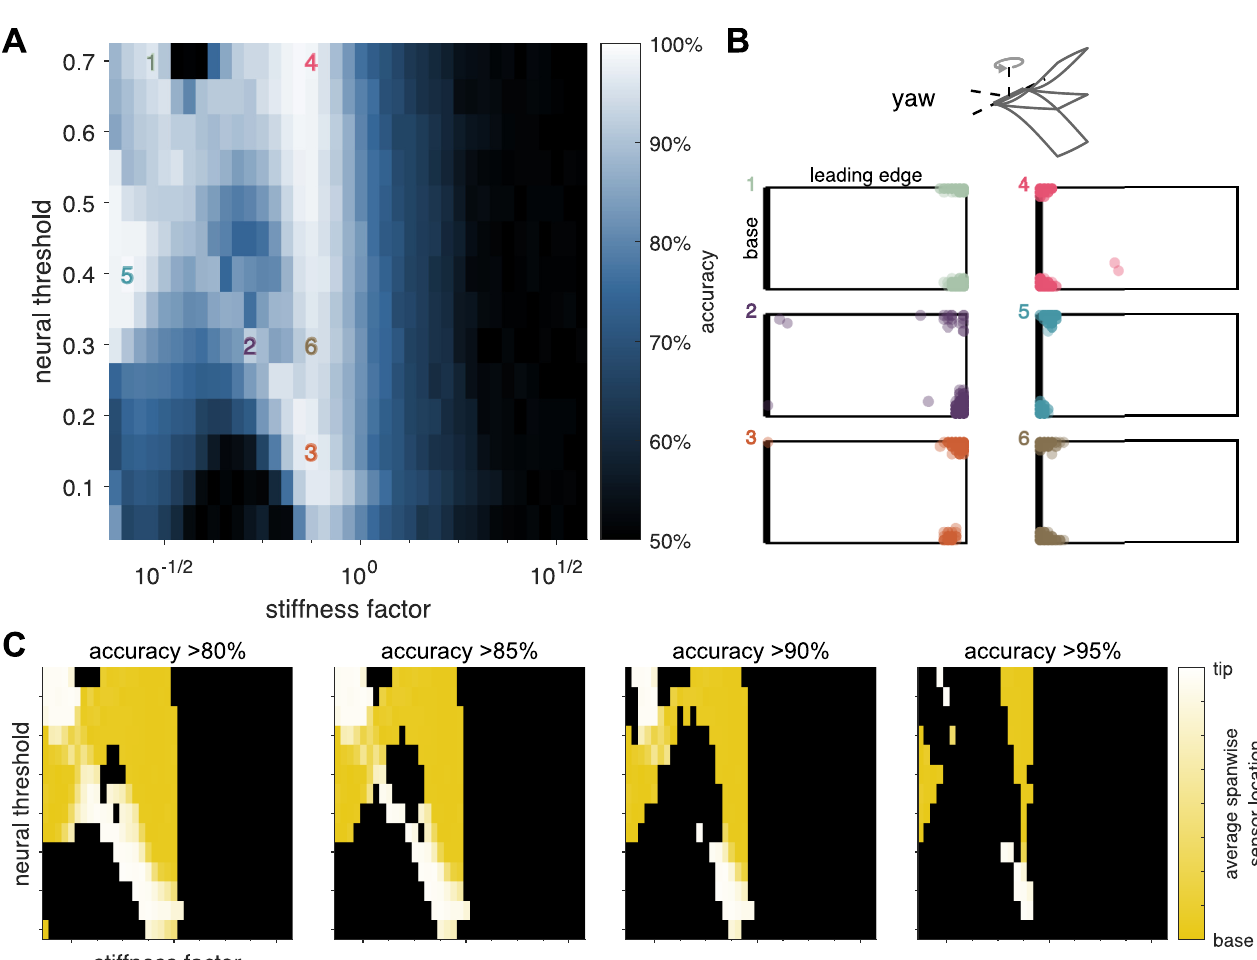
Fig 3. Wing stiffness and neural threshold interact to determine sensor locations and classification accuracy in the yaw axis. A: Accuracy as a function of neural threshold and wing stiffness. B: Optimal sensor locations of 10 best sensors, overlaid for 20 different simulated data sets. Neural threshold and wing stiffness of each panel are indicated by the corresponding colored dot in A. Top : Schematic indicates the axis of rotation. C: Optimal sensor locations in the spanwise direction from wing base (yellow) to wing tip (white) as a function of neural threshold and wing stiffness. Each panel shows results for a different accuracy cutoff. Black indicates parameter combinations that fall below the